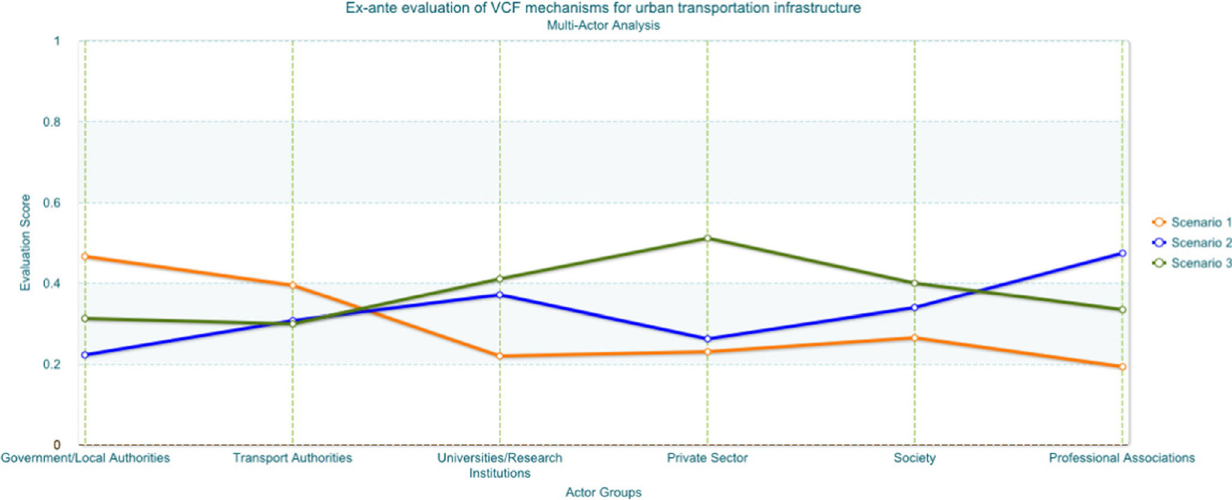
Fig. 5 Multi - Actor Line Chart (MAMCA Software, own